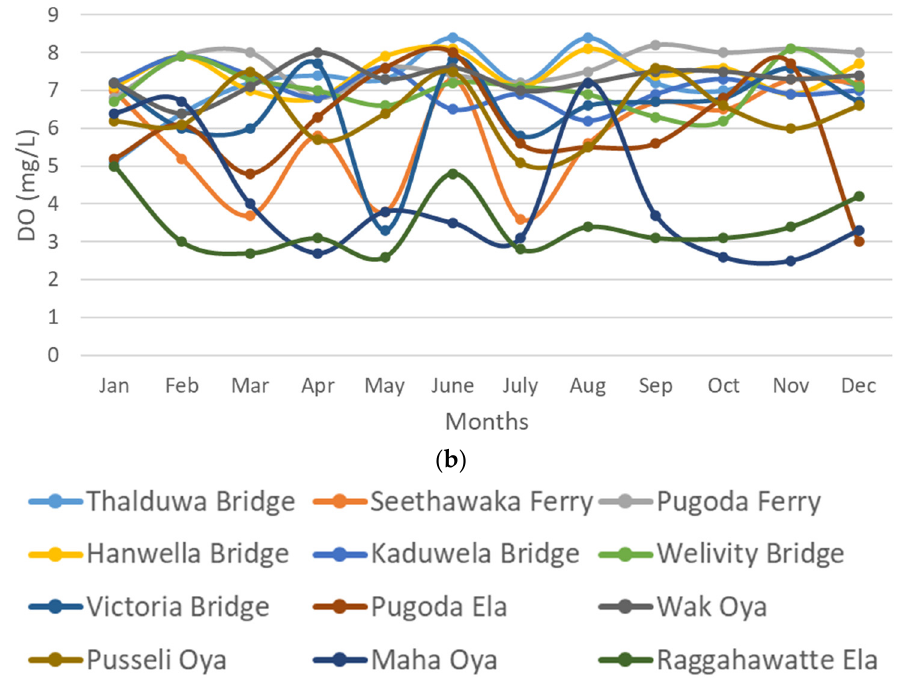
Figure 3. DO variation along the Kelani River basin in ( a ) 2005 ( b ) 2012. Table 2. Minimum DO values along the Kelani